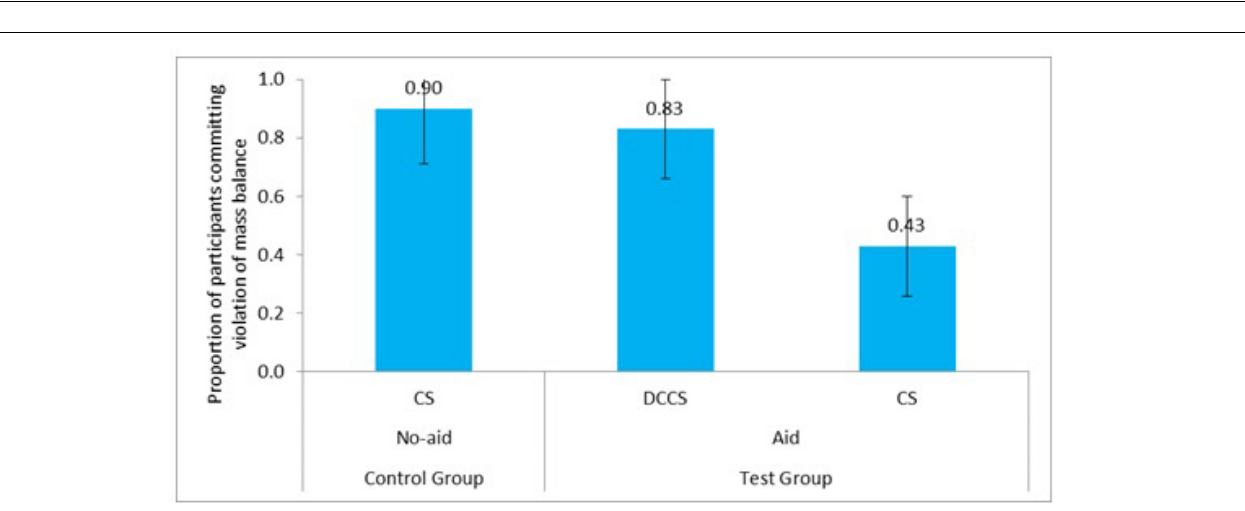
FIGURE 12 | Proportion of participants relying on correlation heuristic in the Aid and No-aid conditions. The error bars represent 95% confidence interval around the point estimate.